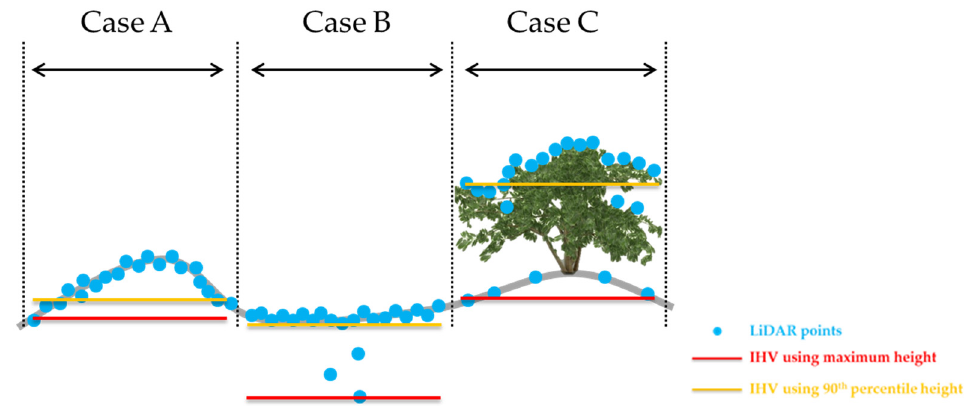
Figure 13. Derived IHV using maximum height and 90th percentile height for three cases: Case A—ground with clean definition; Case B—ground with noise points; Case C—area with dense vegetation.